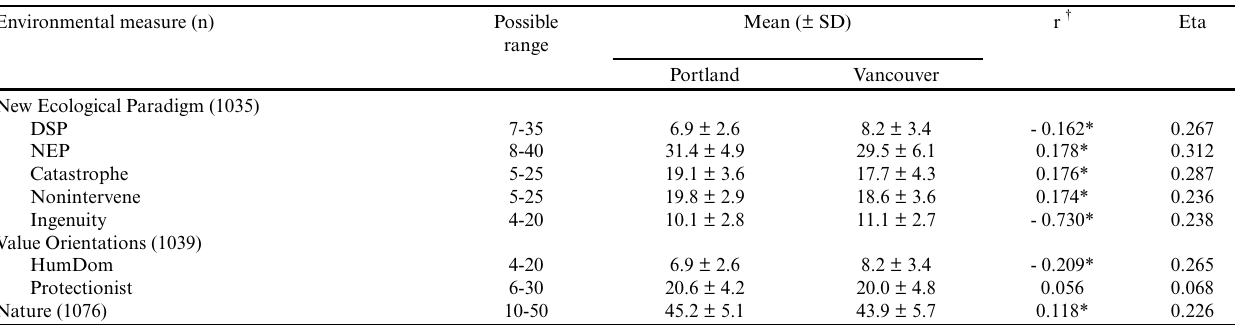
Table 6 . Respondent characteristics for environmental variables.